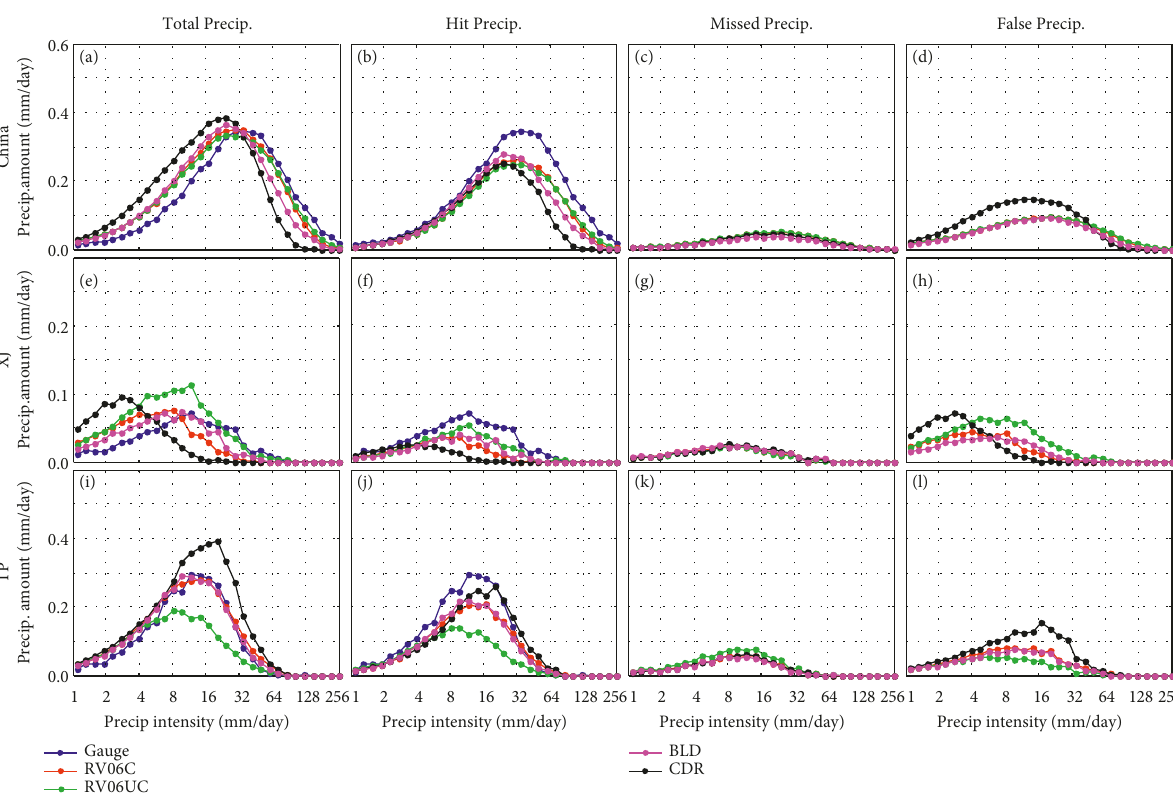
Figure 12: The daily intensity distribution of the total, hit, missed, and false precipitation summer metrics during the period from March 2014 to June 2018 over Mainland China and the XJ and TP subregions. The total precipitation of gauge (blue line) is also shown in the first two columns for